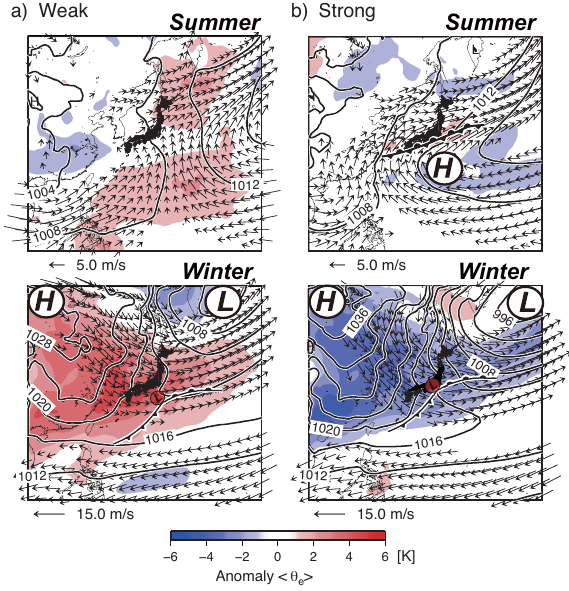
Figure 10. Composite maps of equivalent potential temperatures (cid:104) θ e (cid:105) anomaly (shading: K) sea level pressure (solid contours, con- tour interval 4hPa) and surface wind (vectors: ms − 1 ) for: weak monsoon summers (top left panel); strong monsoon summers (top right panel); weak monsoon winters (bottom left panel); and strong monsoon winters (bottom right